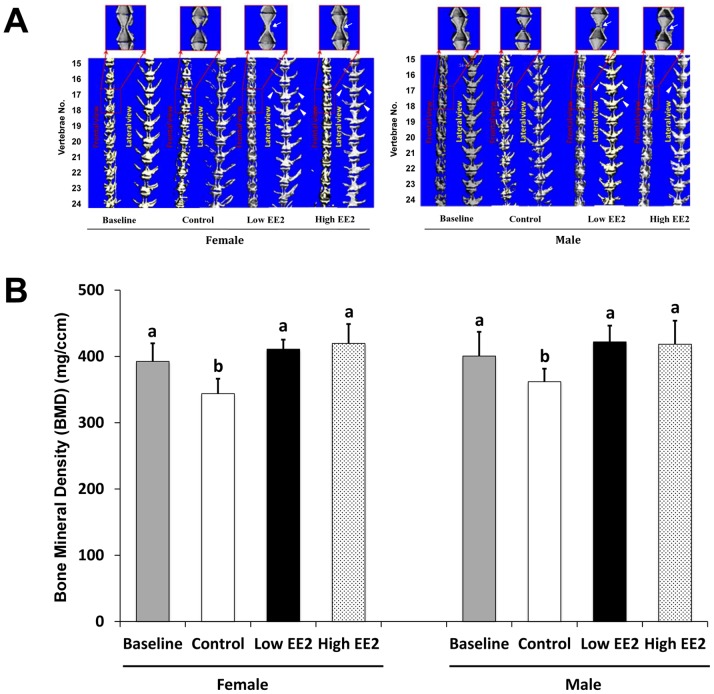
Changes in micro-architecture (A) and bone mineral density (BMD) (B) of vertebrae bodies from 10 months old (baseline) to 11 months old female and male Japanese medaka Oryzias latipes after low and high EE2 treatment for 4 weeks.White arrows and arrowheads indicate improved micro-architecture and arches in EE2 treated fish. Bars labeled by the same letter (a, b) on the graph are not significantly different from each other (P<0.05).